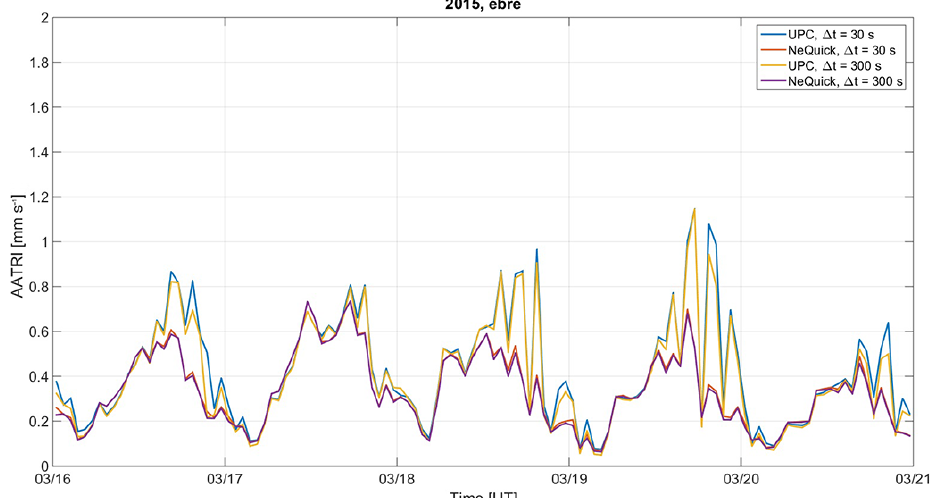
Figure 16. AATR index computed using d t = 30 and 300s for experimental STEC data and STEC data reconstructed after VTEC data ingestion. St. Patrick’s Day storm, March 2015 at Ebre station (Lat = 40.8, Long =